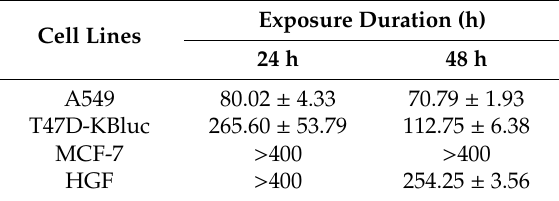
Table 6. IC 50 values ( µ g extract / mL) ± Standard Error obtained by Alamar Blue assay for A549,